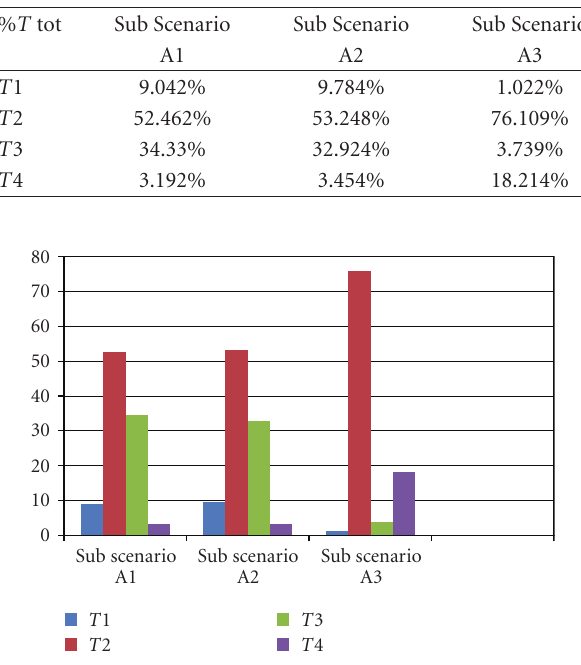
Figure 4: Scenarios a results—BE time measurements